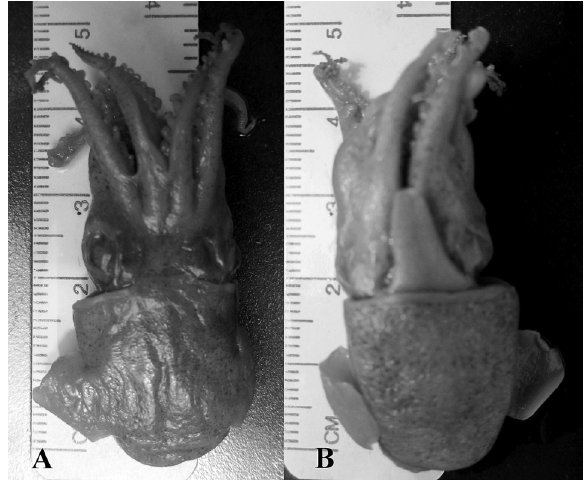
Fig . 2. – Sepiola bursadhaesa n. sp., paratype, MNCN 15.06/226P8, male. A, dorsal view; B, ventral